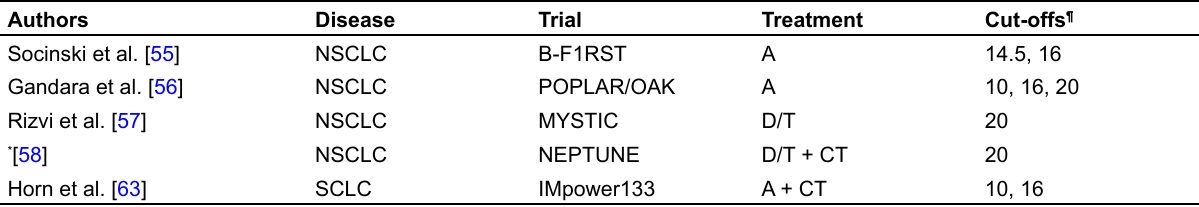
Table 2. Analysis of bTMB in lung cancer clinical